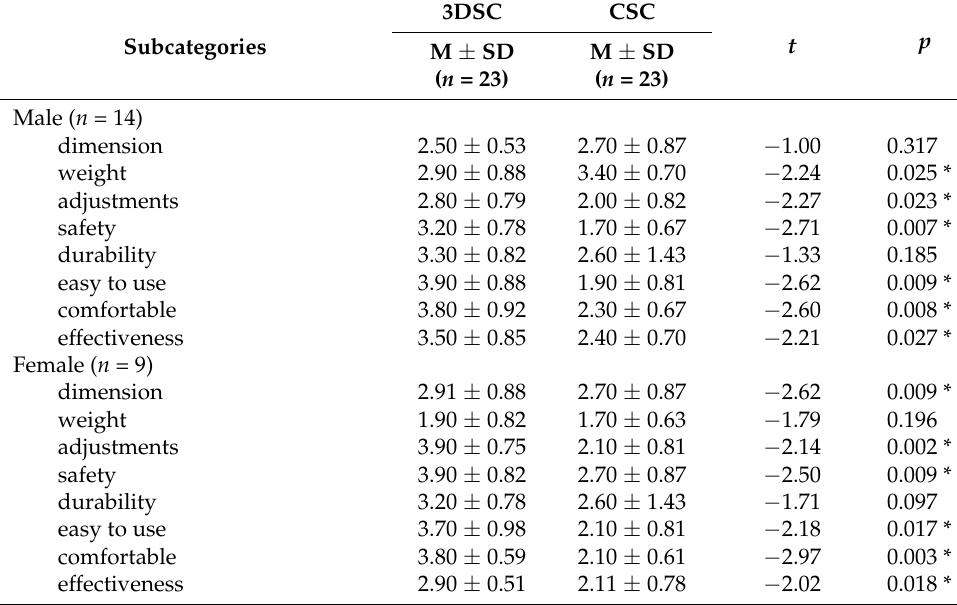
Table 5. Comparison of the QUEST 2.0